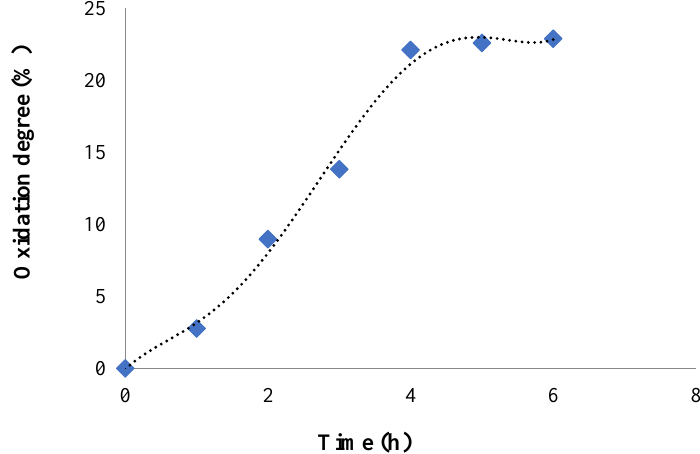
Figure 4 . Variation in time of the oxidation degree of CMC . Figure 4. Variation in time of the oxidation degree of